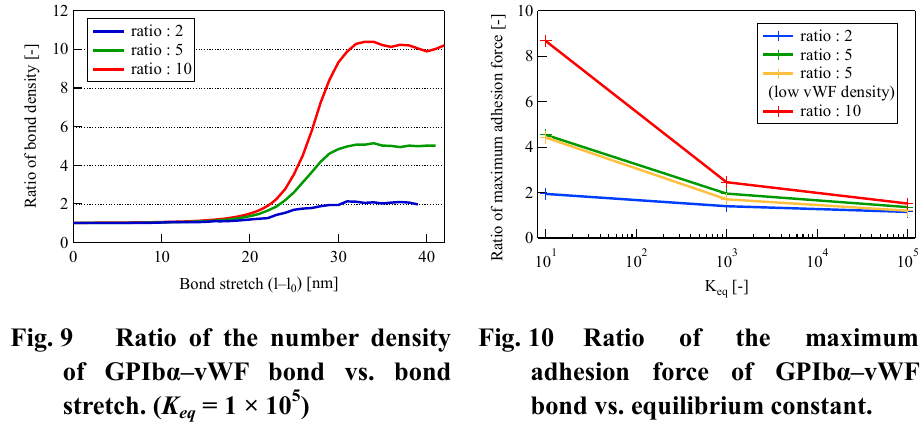
) and breakage ( k f